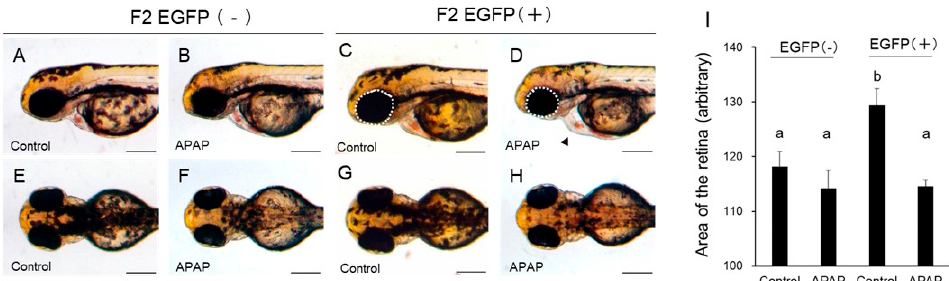
Figure 3. Acetaminophen-induced reduction in the size of the retina in rat CYP2E1-TG larvae. EGFP fluorescence-negative (EGFP [ − ]) and -positive (EGFP [+]) F2 CYP2E1-transgenic larvae were exposed to 2.5 mM acetaminophen (APAP) from 24 hpf to 54 hpf for capture of lateral and dorsal images. ( A , B , E , F ): EGFP [ − ] larvae. ( C , D , G , H ): EGFP [+] larvae. ( I ) indicates quantitative data of lateral area of the retina in the bar graph ( n = 10). The retina was circled by white interrupted line for quantification for example ( C , D ). Scale bar: 200 µm. Bars with different letters in ( I ), (a, b) are significantly different ( p < 0.05). Mild pericardial edema was indicated by arrowhead in D.